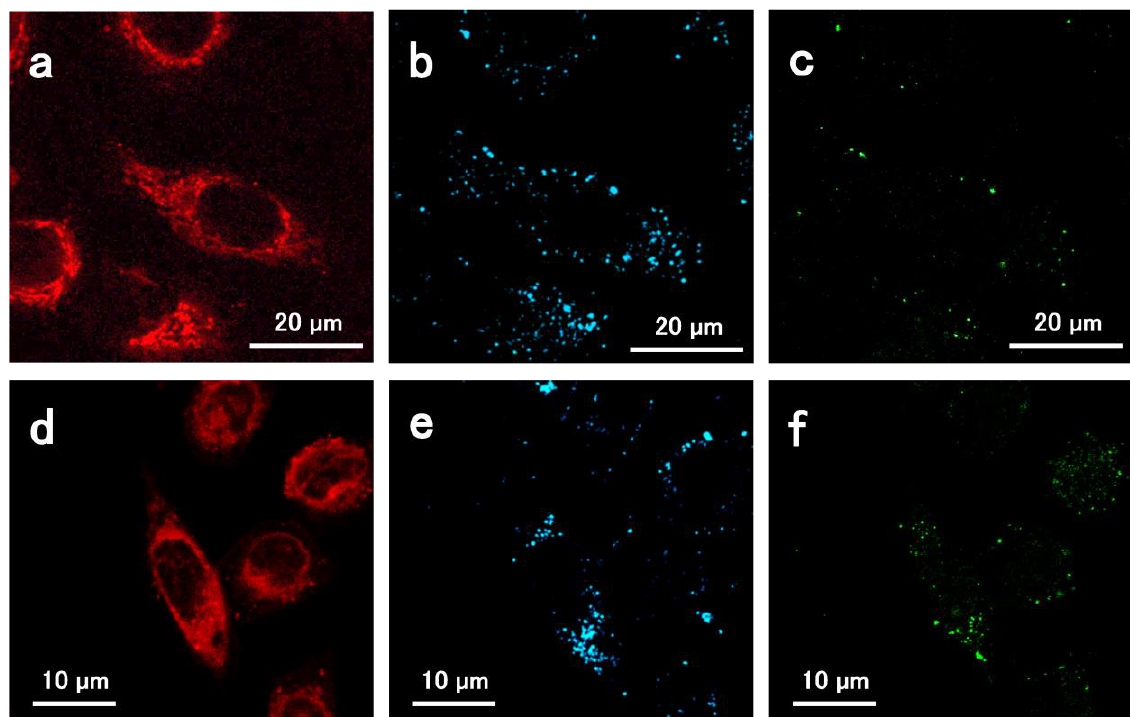
Figure 4. Confocal image of the AuNS-Dox-PEG sample incubated in the A549 cell for 1 h ( a – c ) and 2 h ( d – f ) using 488 nm ( a , d ) and 633 nm ( b , c , e , f ) laser excitation. (Red: doxorubicin fluorescence; blue: gold scattering; green: Raman emission).